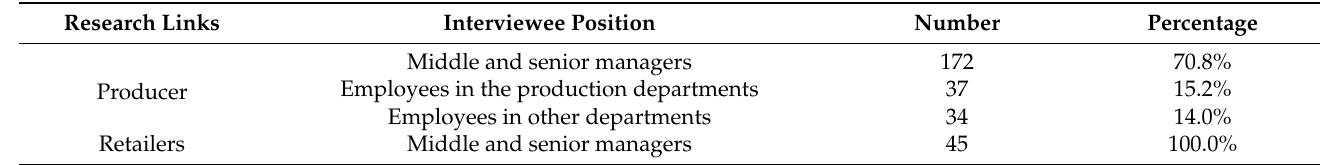
Table 2. Number of interviewees